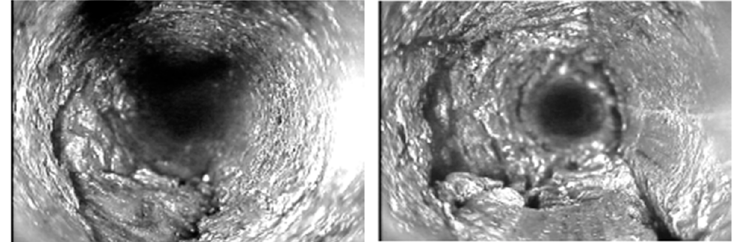
Figure 13. Development characteristic figures of cracks after deep-hole blasting.